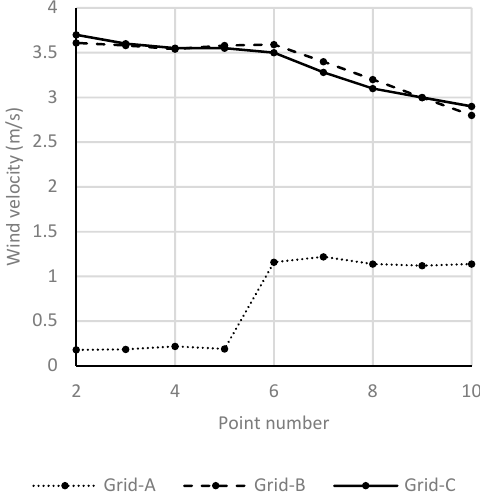
Figure 3. Comparison of the streamwise wind velocity to assess the sensitivity of the grid for the simulation.